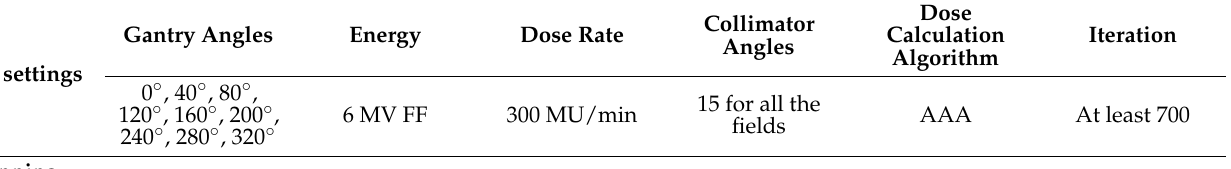
Dose Calculation Iteration Algorithm